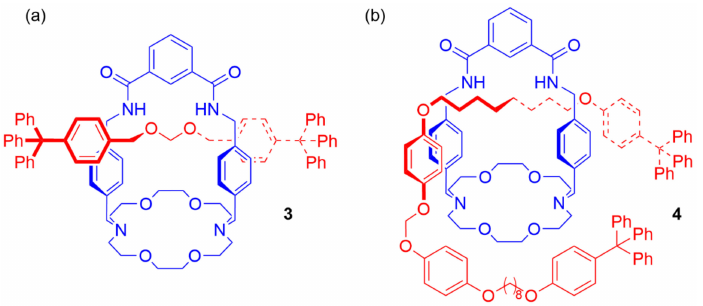
Figure 4. Structures of Smith’s acetal axle rotaxanes 3 ( a ) and 4 ( b